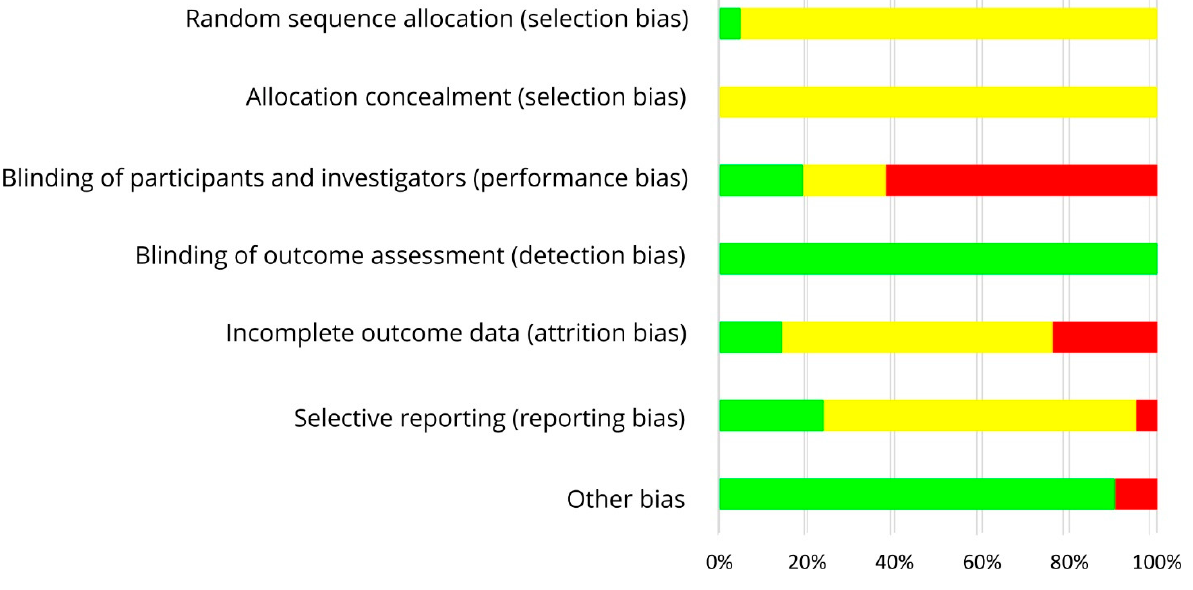
Figure 3. Risk of bias summary across studies with premenopausal women. Green (+), low risk of bias; yellow (?), unclear risk of bias; red ( − ), high risk of bias .